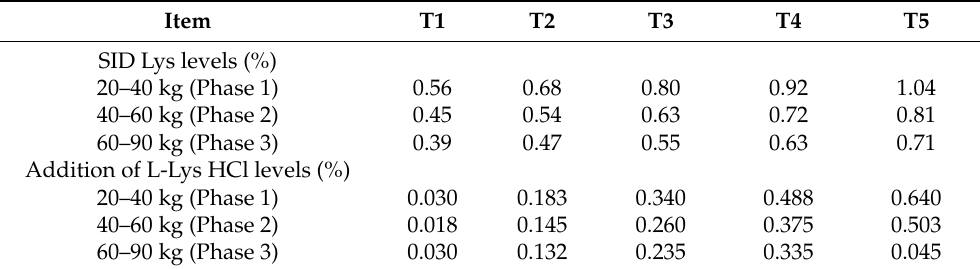
Table 1. The dietary SID lysine and L-lysine HCl supplementation levels of each treatment in the feeding phases.